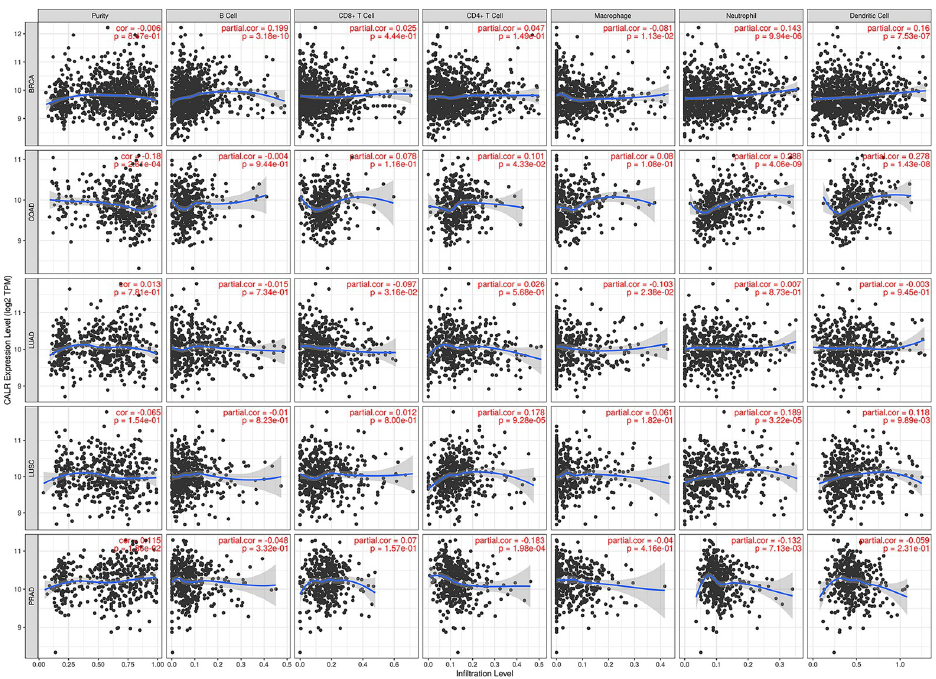
Fig 8. Relationships between CALR and the immune cells infiltration in BRCA, COAD, LUSC, LUAD, and PRAD. P value < 0.05 is considered statistically